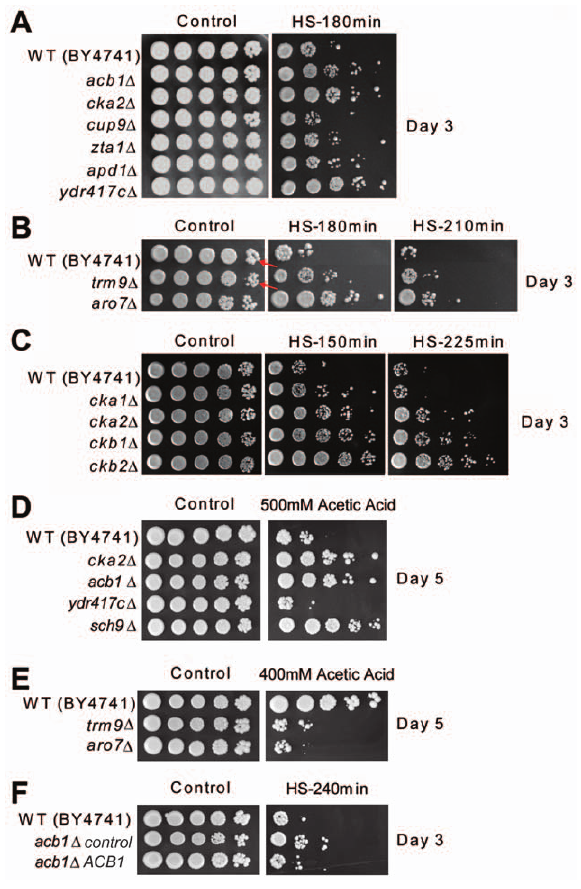
Figure 4. Long-lived mutants are resistant to heat. Day 3 chronologically aging wild type (BY4741) and the following mutants were serially diluted, plated onto YPD plates and heat-shocked at 55 u C for 150–225 minutes: (A) acb1 D , cka2 D , cup9 D , zta1 D , apd1 D , ydr417c D , (B) trm9 D and aro7 D ; in the control panel (highest dilution factor) the arrows indicate the size of the trm9 D colonies (row 2) in comparison with that of the wild type ones (row 1), and (C) cka1 D , cka2 D , ckb1 D , ckb2 D . (D) Day 5 cultures of wild type, acb1 D , cka2 D , ydr417c D , and sch9 D were exposed to 500 mM acetic acid for 180 minutes, serially diluted, and plated onto YPD plates. (E) Day 5 cultures of wild type, trm9 D , and aro7 D exposed to 400 mM acetic acid for 180 minutes. (F) Day 3 cultures of wild type and acb1 D transformed with either a centromeric plasmid carrying a wild type ACB1 gene or a control vector were serially diluted, plated onto YPD plates, and heat-shocked at 55 u C for 240 minutes. The cultures used for the stress resistance experiments were in either SDC (wild type) or SDC-uracil ( acb1 D ).